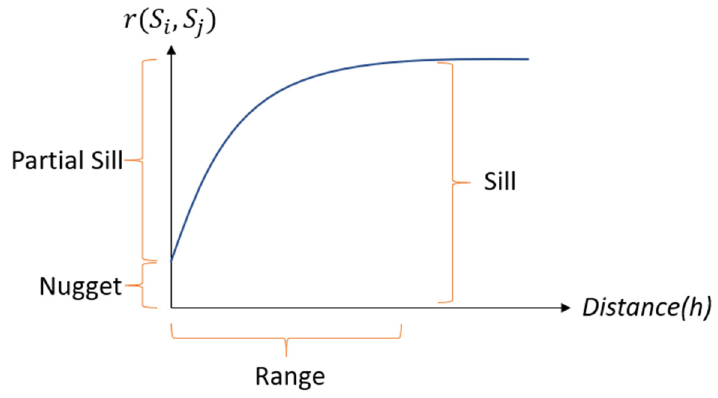
Figure 7. The illustration of semi-variogram.